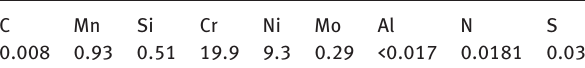
Table 2: Analysis of the 304 stainless steel used in the experiments (in